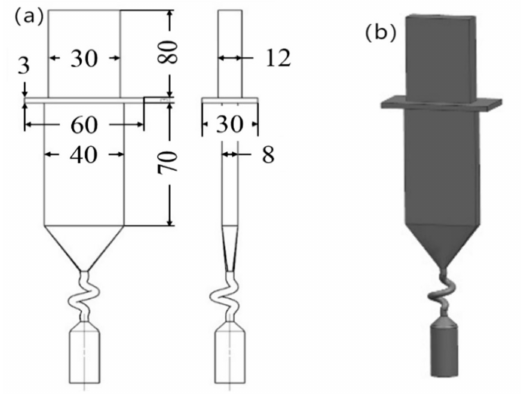
Figure 2. ( a ) The design dimensions of the blade(unit:mm); ( b ) Blade